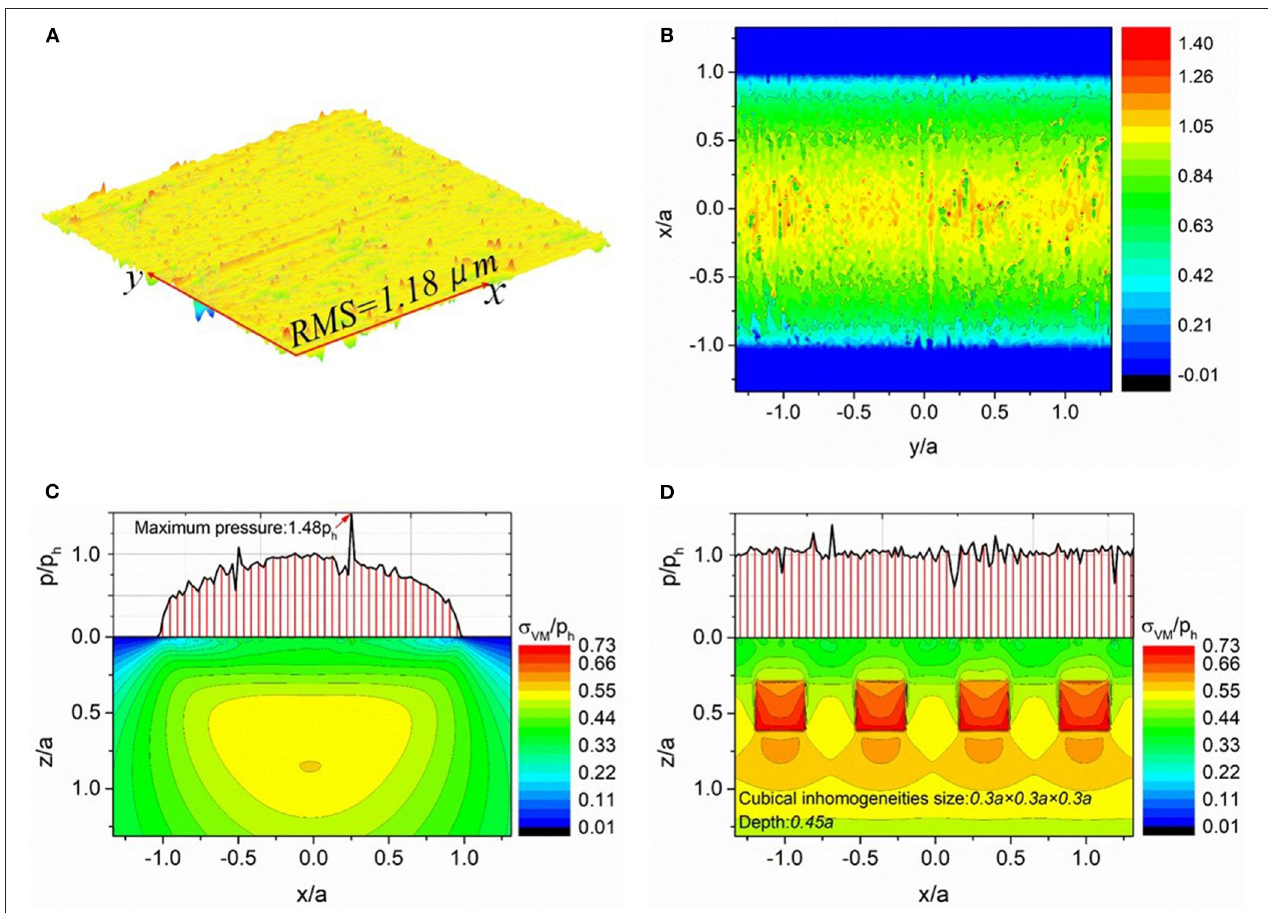
FIGURE 7 | Contact of a cylinder with inhomogeneous half-space and a rough surface (A) and inhomogeneities, 3D pressure distribution on the contact surface (B) , pressure and von Mises stress distributions in the XOZ plane (C) , and pressure and von Mises stress distribution in the YOZ plane (D) . The square inhomogeneities are shown in (D) . Note that (C) cuts through the center of the domain, where no inhomogeneity appears.